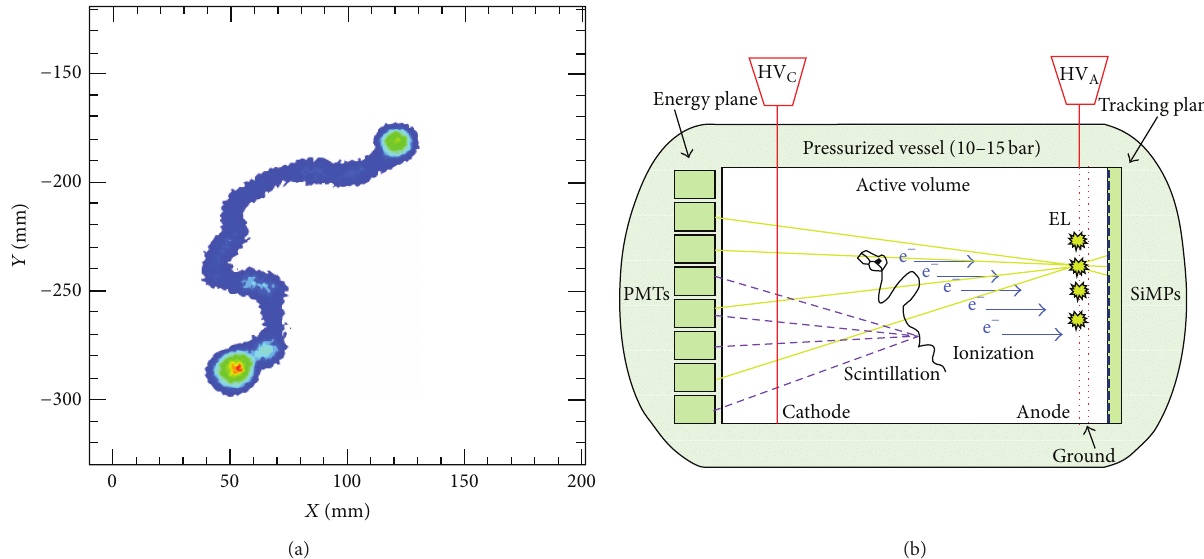
Figure 8: (a) A Monte Carlo simulation of the 𝛽𝛽(0 ] ) ionization track in a 10 bar Xe chamber. (b) The NEXT detector (pictures from [87]).